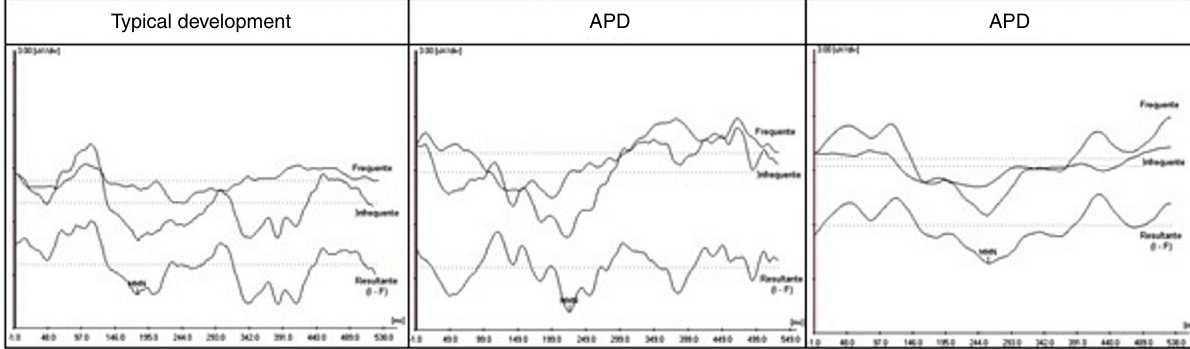
Fig. 2 Mismatch negativity (MMN) tracings for the contrasts of /ga/ (frequent) and /da/ (rare) stimuli and that observed (rare- frequent) in an individual with typical development (TD), an individual with APD, and another with SLI. APD, auditory processing disorder; SLI, specific language